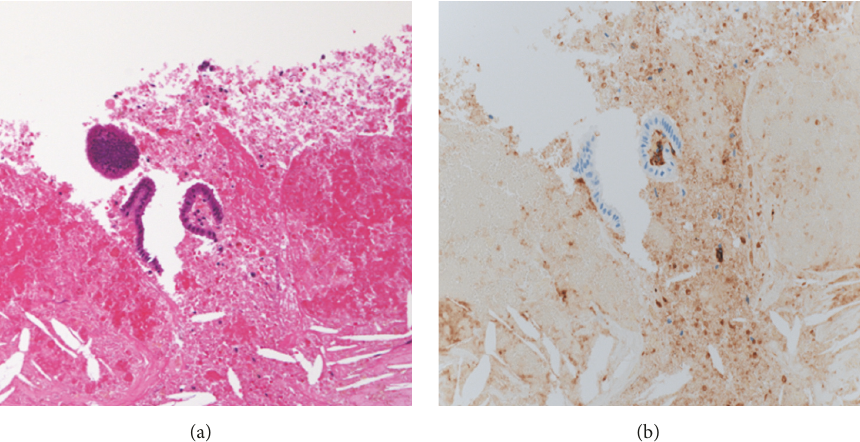
Figure 3: Microscopic findings using hematoxylin and eosin (HE) staining (a) and CD10 (b). We identified the endometrial gland tissues using HE staining and CD10-positive stromal cells using immunohistochemical